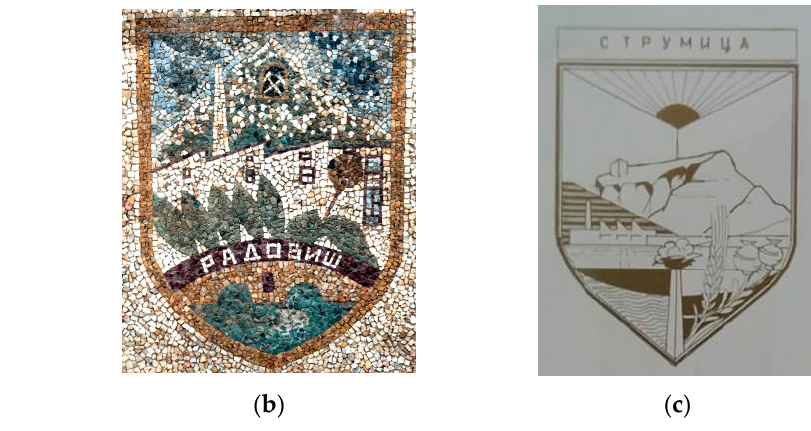
Figure 16. ( a ) Arms of Bitola; ( b ) Arms of Radovish; ( c )Arms of